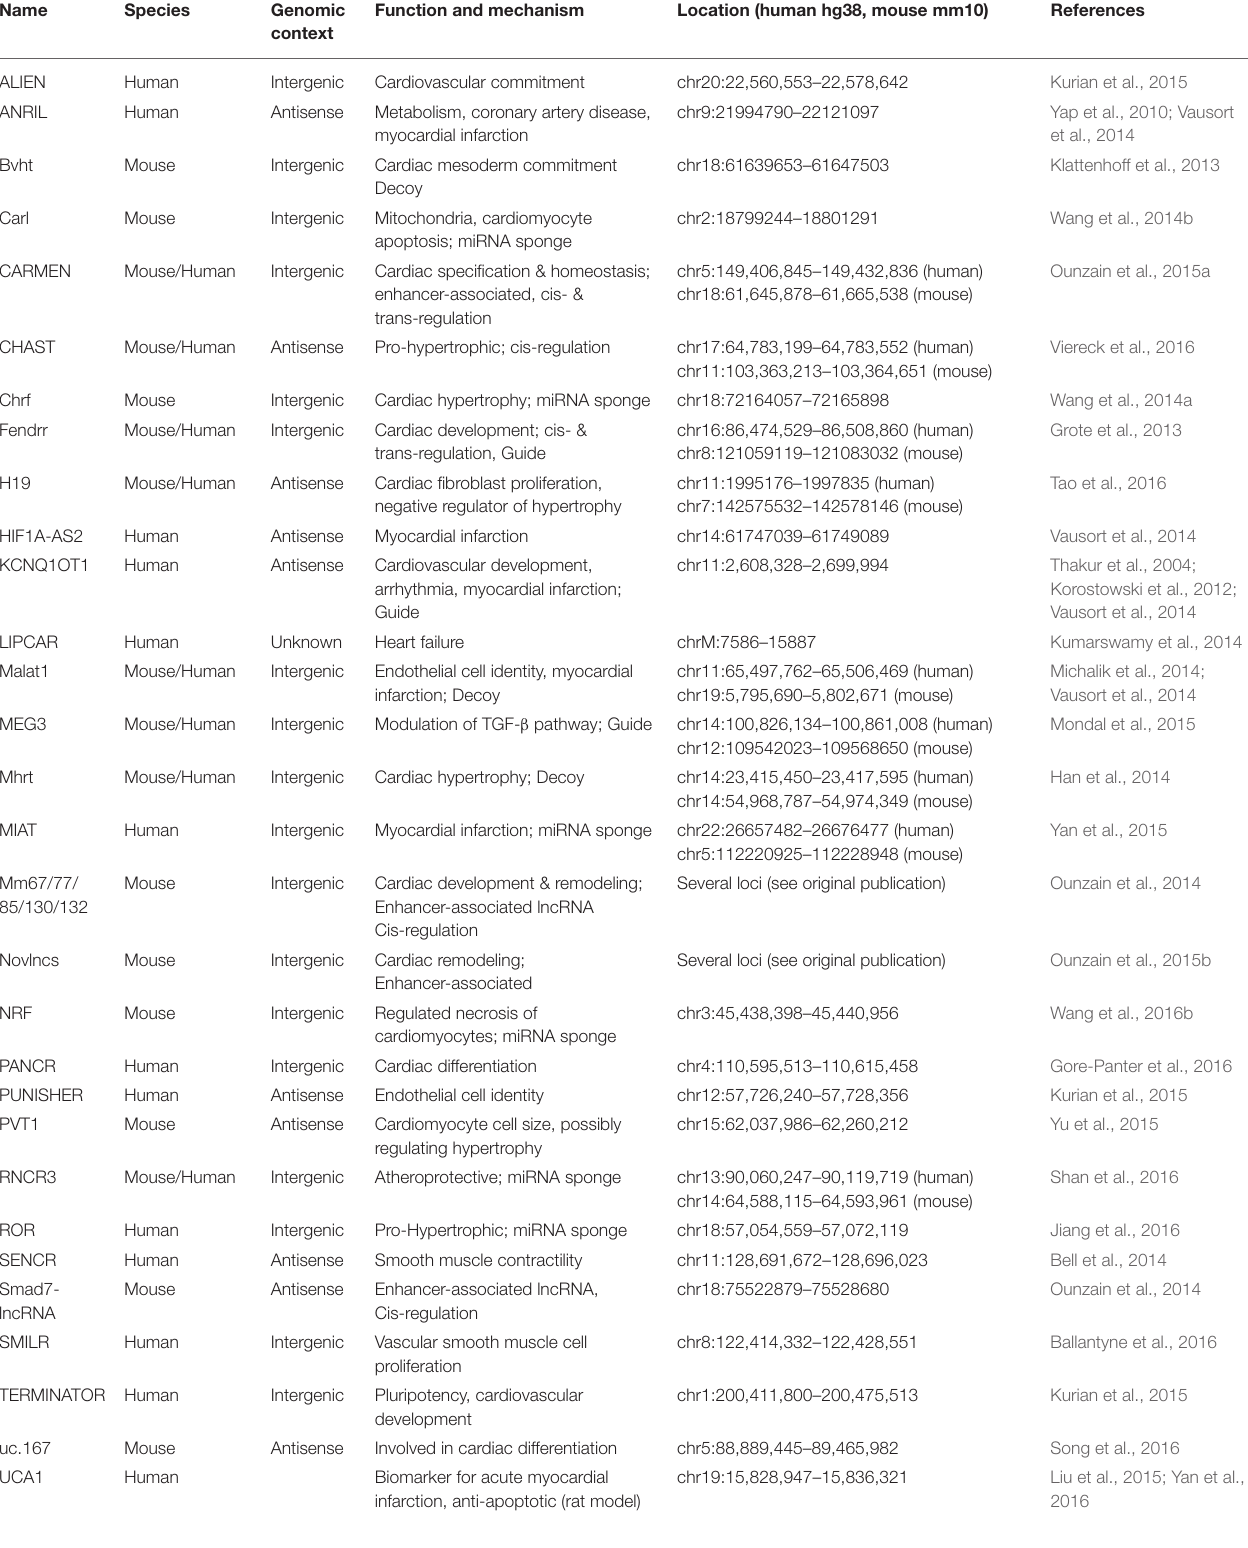
TABLE 1 | Summary of lncRNAs involved in cardiac development and